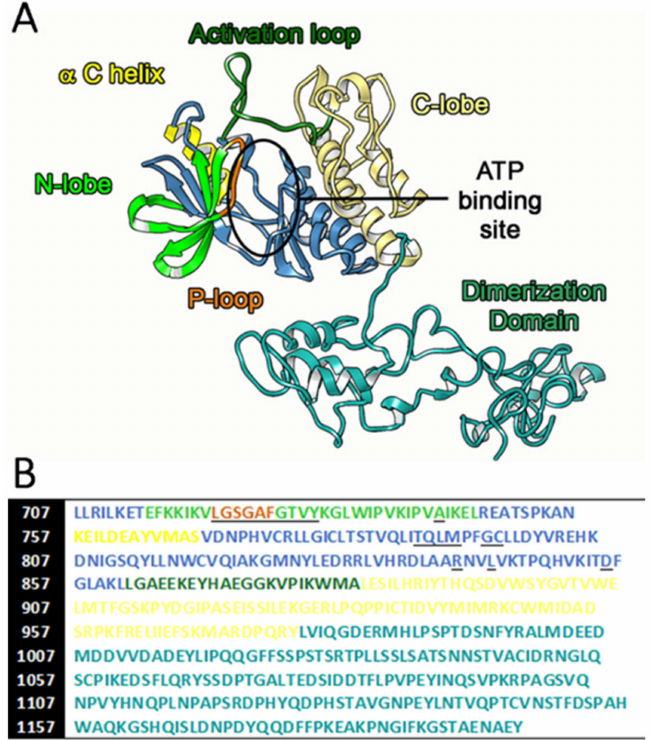
Figure 2. The complete structure of wild type EGFR cytoplasmic tyrosine kinase (TK) domain after molecular dynamic (MD) simulation ( A ) and the corresponding FASTA sequence ( B ). For clarity, we reported the same color index on both figures, while the underlined aminoacids make up the ATP binding